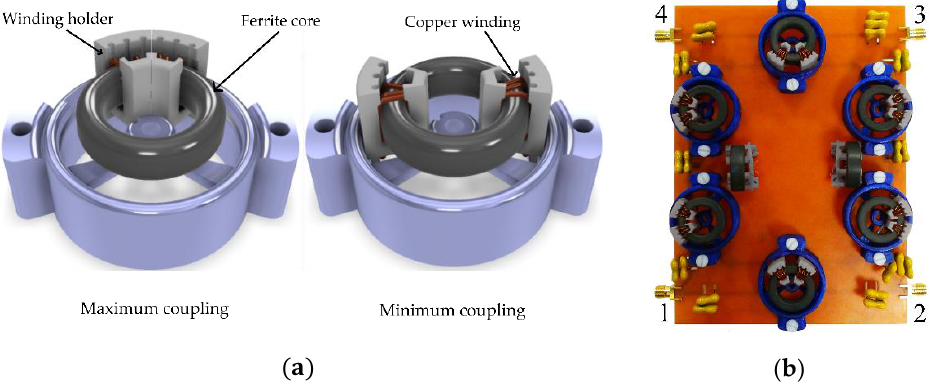
Figure 6. MI directional filter: ( a ) mechanism for tuning of magnetic coupling (LH–maximum coupling; RH–minimum coupling); ( b ) complete PCB with labelled port numbers.